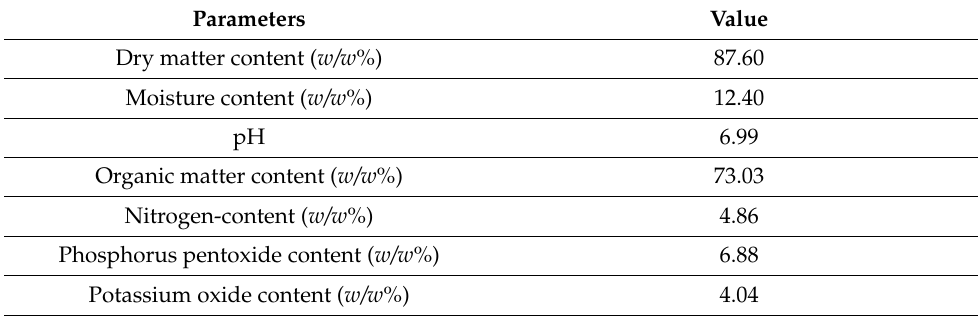
Table 1. Characteristics of evaluated product.